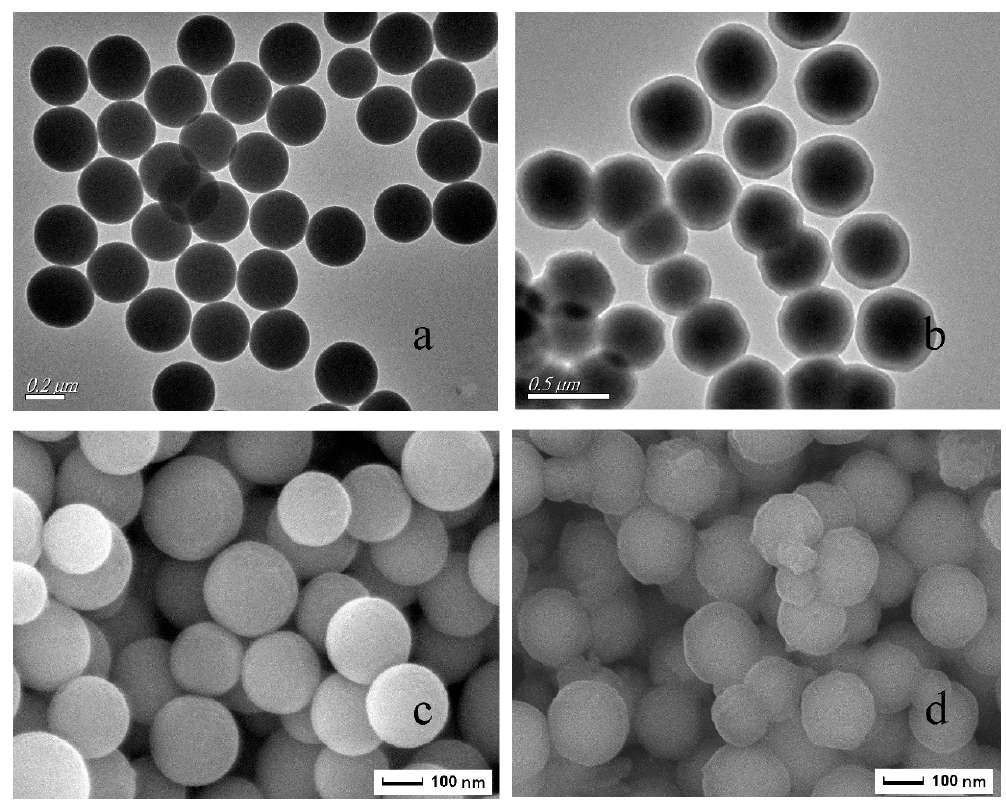
Figure 4. The transmission electron microscope (TEM) images of SiO 2 ( a ), MIPs ( b ) and the scanning electron microscope (SEM) images of SiO 2 ( c ), MIPs ( d ).